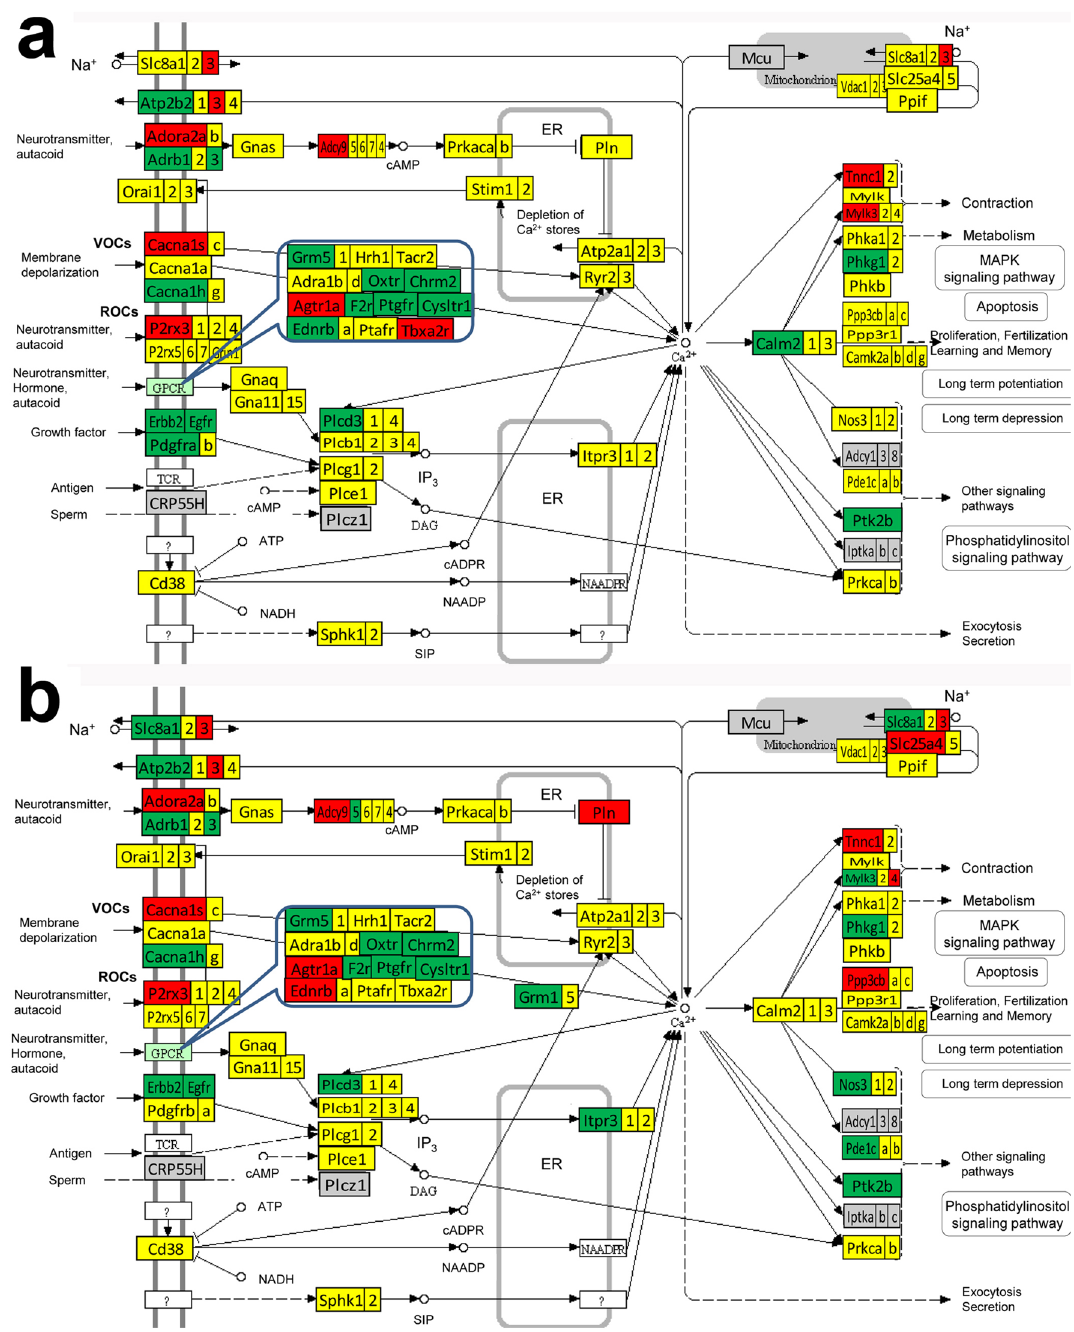
Figure 6. KEGG map ( modified from https ://www.genom e.jp/dbget -bin/www_bget?mmu04 020) of the differential expression of calcium signaling (CAS) genes in: a. left ventricle vs left atrium, b. right ventricle vs right atrium. Red/green/yellow background of gene symbol indicates up-/down-/not regulated. Red/green/ yellow background of the gene symbol indicates up-/down-/not regulated. Not quantified genes are on grey background. Genes with significant differences: Adcy5, Adcy9 , adenosine A2a receptor ( Adora2a ), adrenergic receptors ( Adrb1, Adrb3 ), Agtr1a , Atp2b2, Atp2b3 , Cacna1h, Cacna1s , Calm2 , Chrm2 , cysteinyl leukotriene receptor 1 ( Cysltr1 ), Ednrb , epidermal growth factor receptor ( Egfr ), v-erb-b2 erythroblastic leukemia viral oncogene homolog 2 ( Erbb2 ), F2r , Grm5 , inositol 1,4,5-triphosphate receptor 3 ( Itpr3 ), myosin light chain kinases ( Mylk3, Mylk4 ), Nos3 , Oxtr , P2rx3 , phosphodiesterase 1C ( Pde1c ), Pdgfra, phosphorylase kinase gamma 1 ( Phkg1 ), Plcd3, phospholamban ( Pln ), Ppp3cb , Ptgfr , PTK2 protein tyrosine kinase 2 beta ( Ptk2b ), Slc8a1, Slc8a3 , thromboxane A2 receptor ( Tbxa2r ) and troponin C cardiac/slow skeletal ( Tnnc1